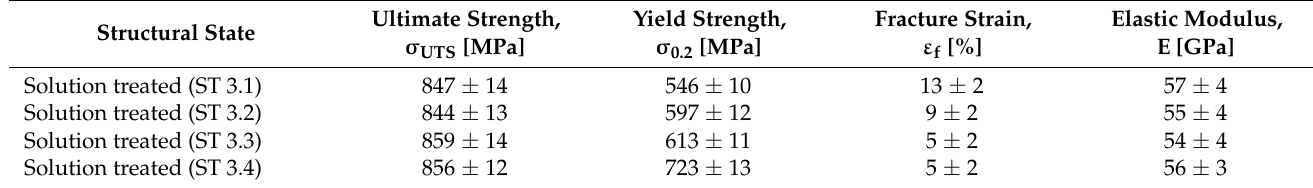
Table 7. Mechanical characteristics of TNTZ alloy solution treated at 1000 ◦ C with holding times